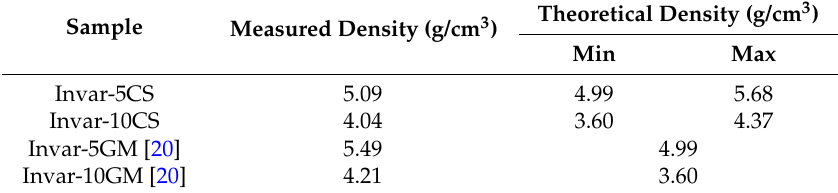
Table 1. The measured and theoretical densities of Invar SF with cenospheres (CS) and glass microspheres (GM) as